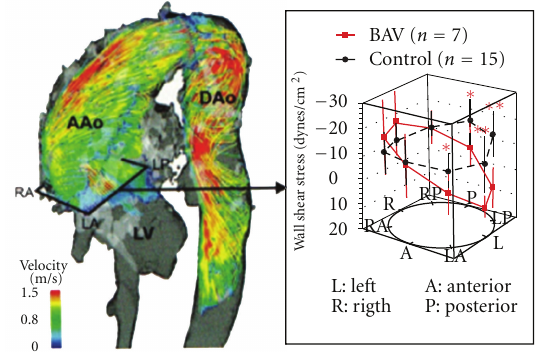
Figure 5: Di ff erences in aortic wall shear stress in BAV patients versus TAV controls